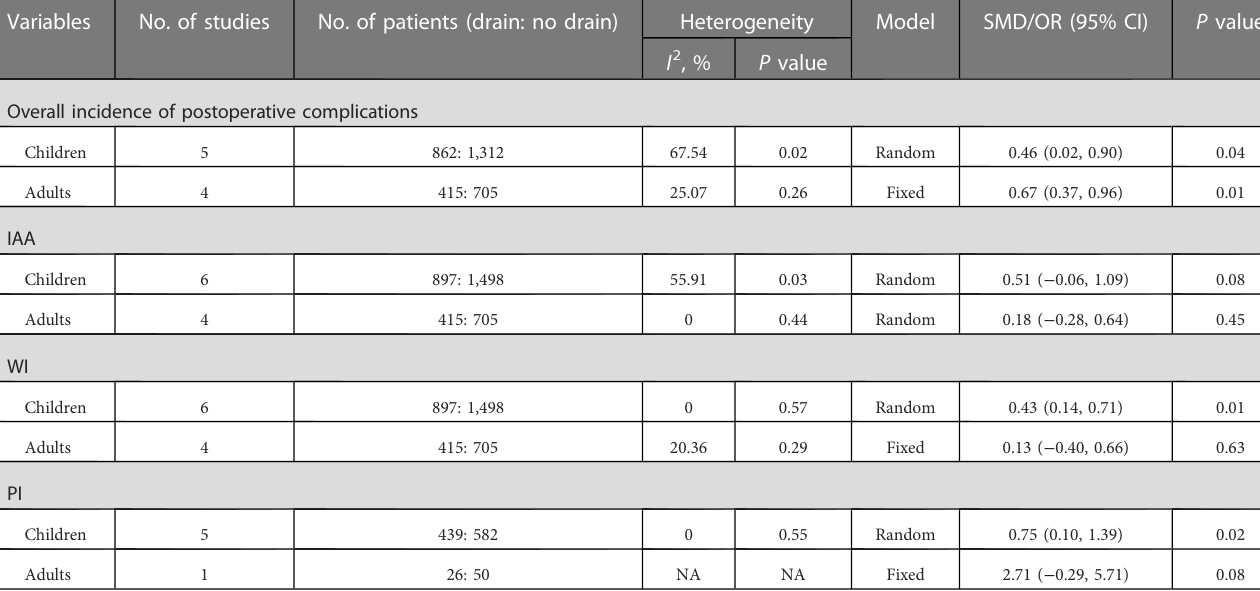
TABLE 4 Subgroup meta-analysis of postoperative complications. Variables